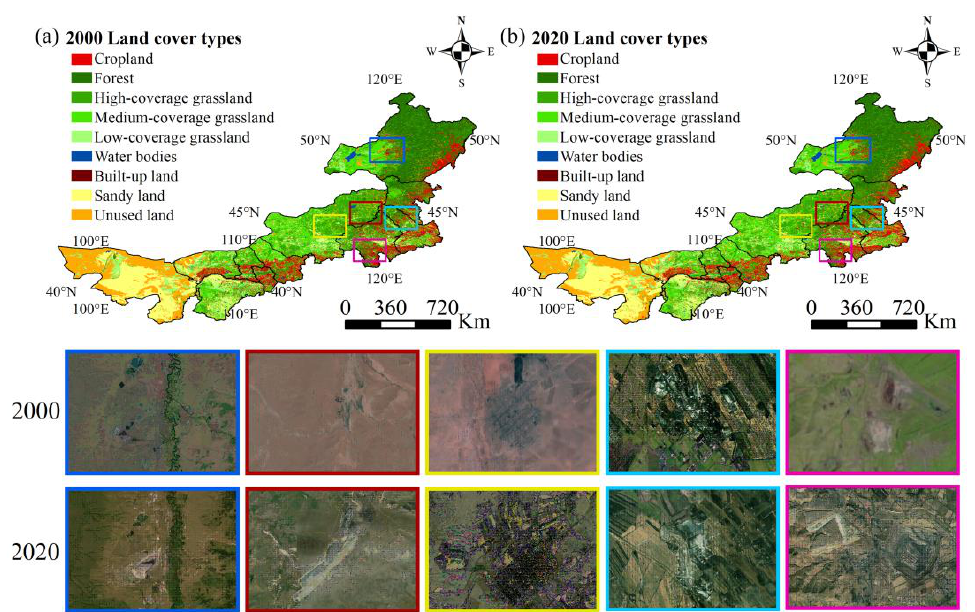
Figure 11. Sankey maps of land use transformations in Inner Mongolia from 2000 to 2020.